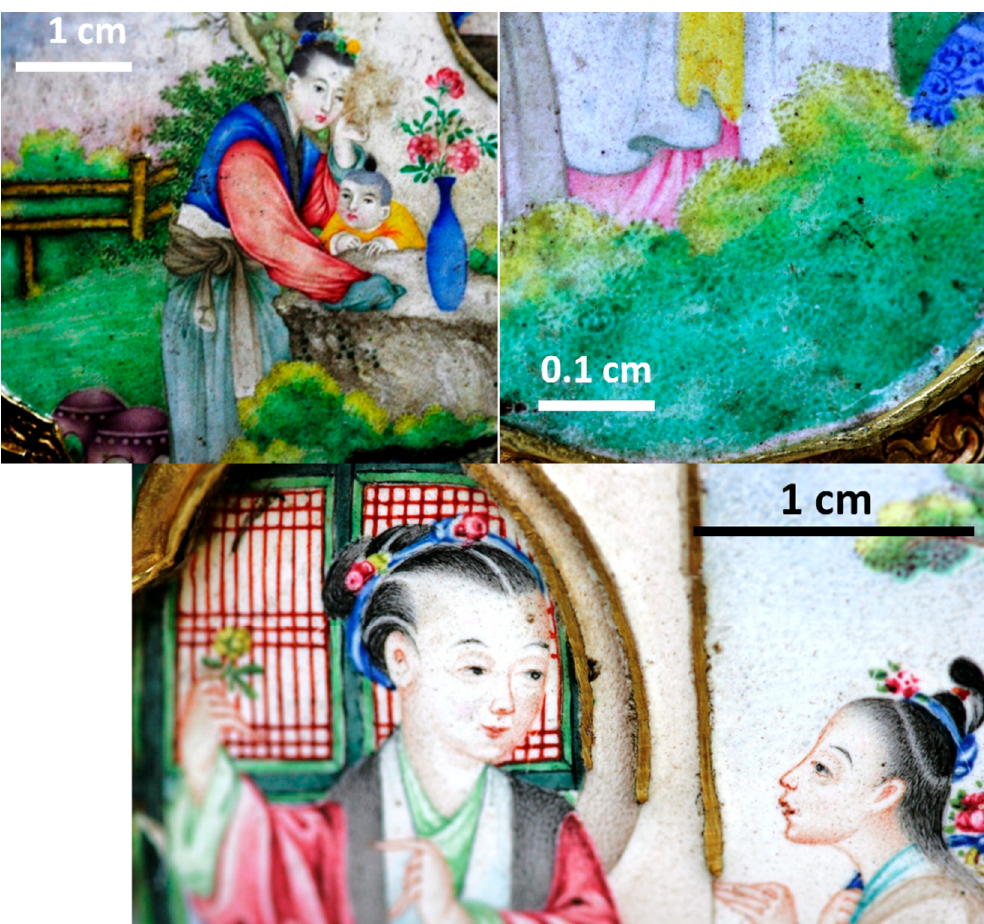
Figure 11. Images of the painted décor and zoom of the green foliage showing the use of dots of different hues and different painting techniques (spitting or brush touch).